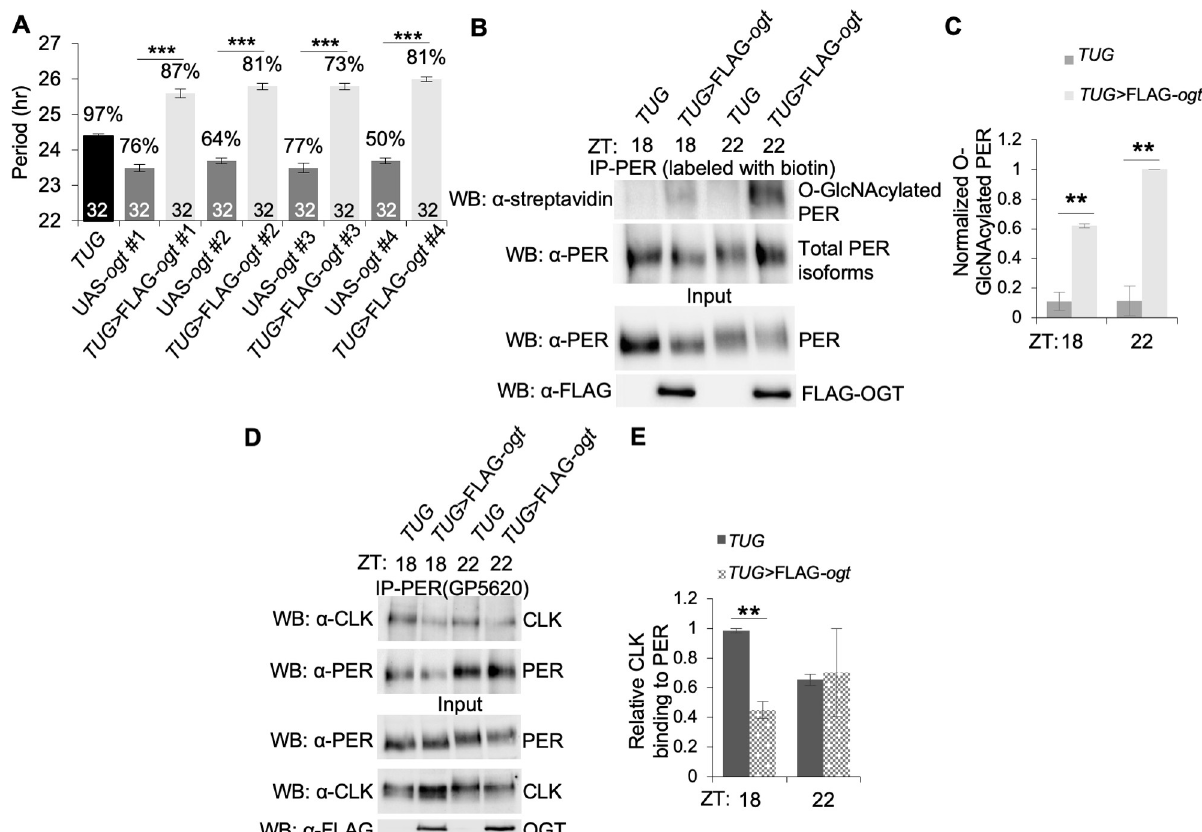
Fig 5. OGT overexpression in clock neurons lengthens behavioral rhythms and disrupts PER-CLK interaction. (A) Four independent transgenic fly lines expressing 3XFLAG-tagged ogt in tim- expressing neurons ( TUG > FLAG -ogt ) display lengthened periods in free-running locomotor activity rhythms as compared to their parental controls. Black and dark grey bars represent control parental lines. Light grey bars represent independent TUG > FLAG -ogt transgenic lines. Numbers above bars indicate percentage of flies displaying rhythmic activities. Asterisks above percentage denote statistical significance ( ��� P -value < 0.001) in period lengths of transgenic flies expressing TUG > FLAG- ogt as compared to their parental controls. Numbers within bars indicate sample size (number of flies). Error bars indicate ± SEM. (B) PER O-GlcNAcylation is enhanced in TUG > FLAG -ogt (line 4 is used for all subsequent experiments). Protein extracts from fly heads at the indicated time-points were either directly analyzed by immunoblotting (input) (Bottom two panels) or immunoprecipitated with α -PER (GP5620), followed by chemoenzymatic labeling with biotin. Samples were resolved on SDS-PAGE and analyzed by western blotting using α -streptavidin or α -PER (Top two panels). (C) Bar graph showing normalized O-GlcNAcylated PER in ogt overexpressor and control flies (n = 2). Error bars represent SEM. �� P = 0.01; two tailed Student’s t test. (D) Western blots showing reduced PER-CLK binding in ogt overexpressor flies at ZT18 but not at ZT22 as compared to control flies. (E) Bar graph showing quantification of CLK immunoprecipitated by α -PER (GP5620) (n = 2). Error bars = SEM. �� P = 0.01; two tailed Student’s t